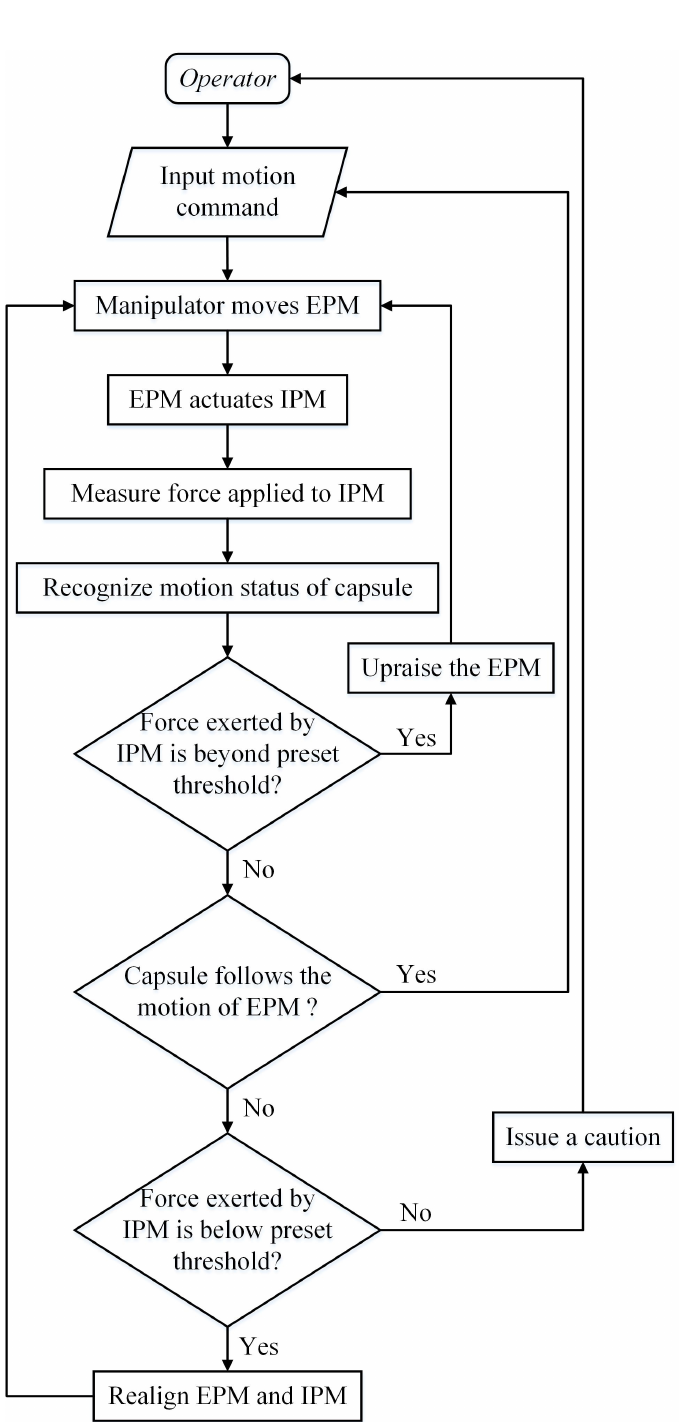
Figure 11. The control flow chart of the designed magnetic capsule endoscope